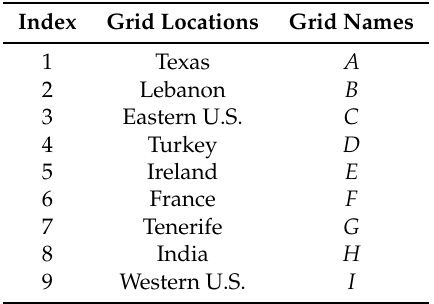
Table 1. Grid Location-Stamp Information of the Training